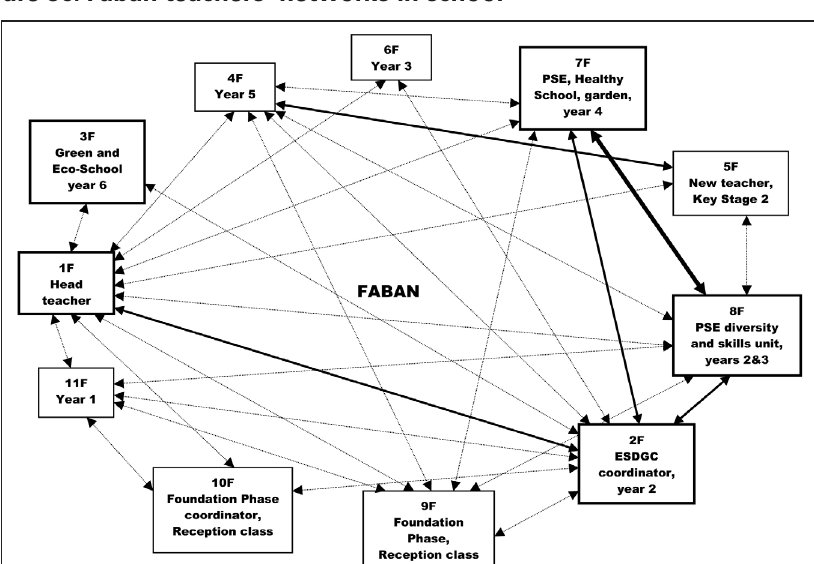
Figure 3c: Faban teachers’ networks in